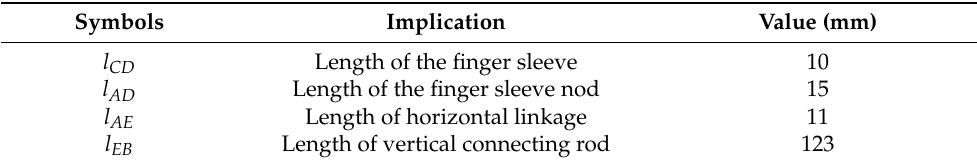
Table 2. Parameters of the preset components.